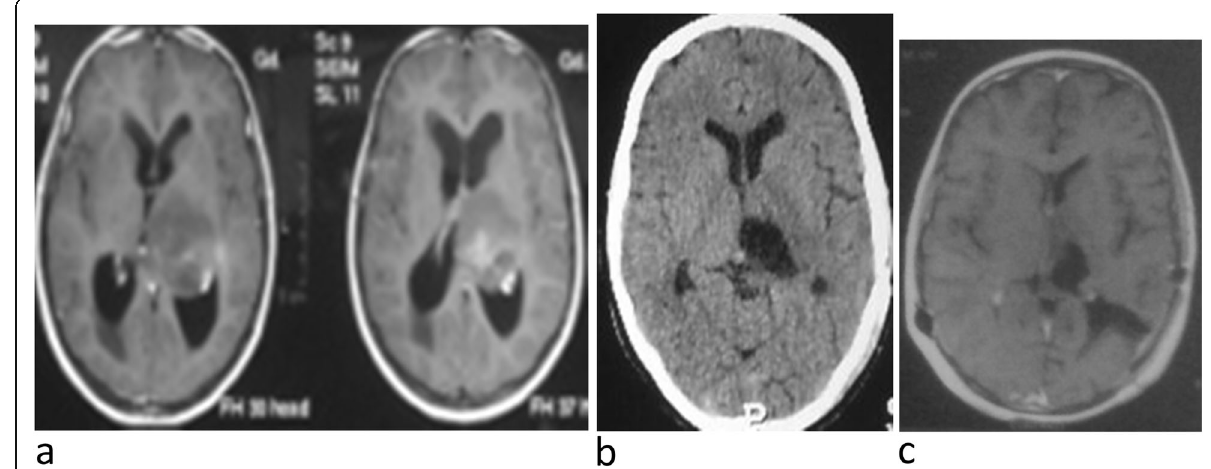
Fig. 10 a On the left MRI axial T1 contrast for left total thalamic pilocytic astrocytoma, b on the right follow up CT after 3 months showing complete removal through parietal transcortical approach, c bottom MRI axial T1 contrast done after 6 months follow up with gross total